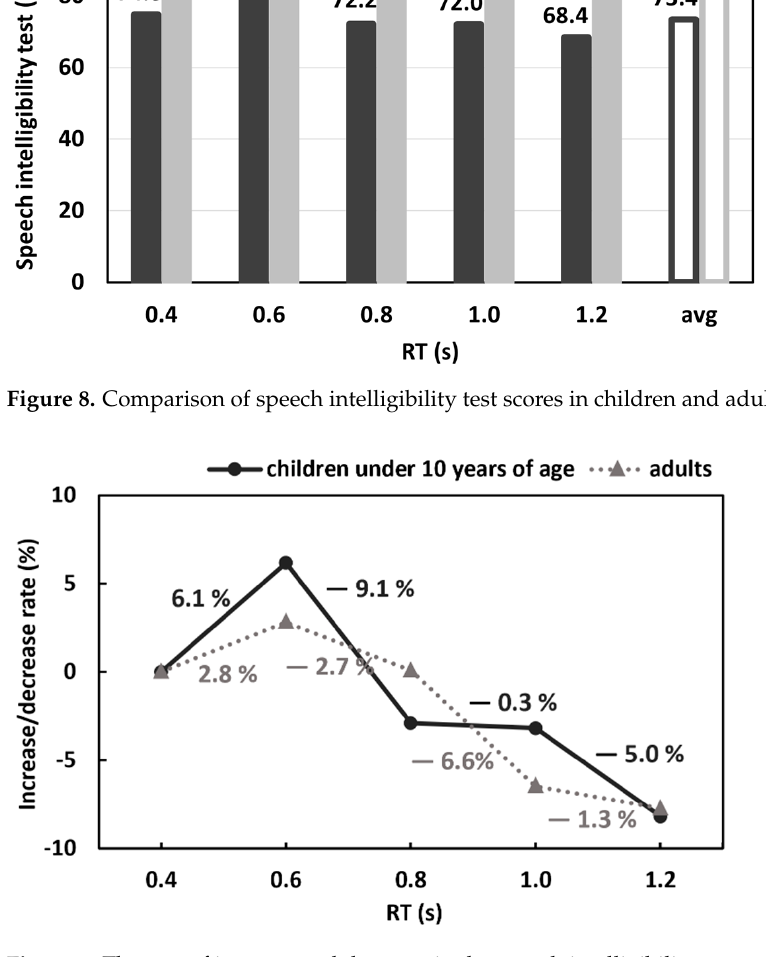
Figure 9. The rate of increase and decrease in the speech intelligibility test scores.